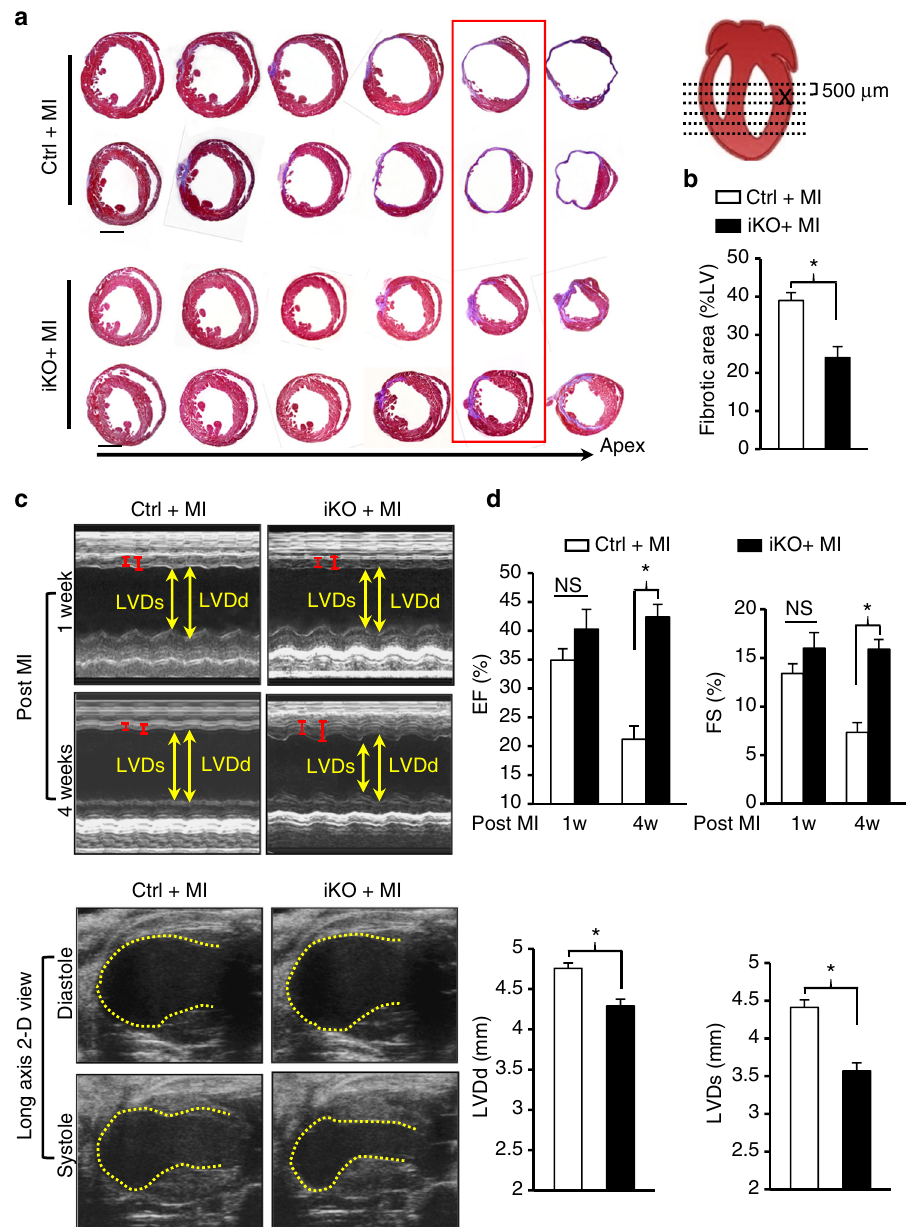
Fig. 9 MiR-128 deletion promotes adult cardiac regeneration after MI. a Representative images of Masson trichrome-stained heart section at 28 days after MI. Serial sectioning was performed at 500 µ m intervals. The most signi fi cant difference between two groups is highlighted by the red box. Scale bars, 1 mm. b Measurement of fi brotic areas in heart sections following MI in control and iKO mice analyzed by Masson trichrome staining. ( n = 8). c , d Heart function analyzed by echocardiography and quanti fi ed by LVDd, LVDs, EF, and FS ( n = 6). Control (Ctrl) mice were miR-128 fl / fl mice, iKO mice were α - MHC MerCreMer ; miR-128 fl / fl mice. Statistical signi fi cance was calculated using Student ’ s t -test in b , d . Data are represented as means ± SEM. * P < 0.05. NS, not signi fi Mice with doxycycline-inducible CM-speci fi c overexpression of miR-128 ( miR- conditional knockout (cKO) region and homology arms, the targeting construct 128-3p ) were generated by crossing α -MHC -tTA (The Jackson Laboratory) mice also contains Frt sites fl anking the neomycin cassette for positive selection and a with miR-128 TetRE mice, in which tetracycline-responsive transcriptional activator DTA cassette for negative selection. The construct was linearized with NotI and (tTA) expression is under the control of α -MHC promoter. Doxycycline (Dox, electroporated into C57BL/6N ES cells. After G418 selection, three-positive clones Harland Laboratories) containing diet was administered to repress transgene were identi fi ed from 280 G418-resistant clones by PCR screening. The positive expression. clones were expanded and further analyzed by Southern blot. The random inte- gration of extra copies of targeting construct was excluded by hybridization with a neomycin probe. To generate chimeras, ES cell clones were microinjected into Generation of mice with a conditional deletion of miR-128 . A construct was blastocysts, and the blastocysts were implanted into pseudo-pregnant foster mice engineered for conditional disruption of the miR-128 ( miR-128-3p ) gene in which a by Cyagen Biosciences Inc. Chimeric males were bred with Flp deleter mice 1.7kb fragment spanning the miR-128 gene was fl anked by two loxP sites. The 1.7 from Jackson Laboratories to generate neomycin-free fl oxed mice. The correct kb fragment, the 5.4 kb left homology arm, and the 2.9kb right homology arm were integration of loxP sites and the successful removal of the neomycin cassette were ampli fi ed from C57BL/6 BAC DNA and cloned into the pBasicLFNeoFL vector con fi rmed by PCR analysis with the primer listed in Supplementary Table 1. sequentially by in-fusion cloning and con fi rmed by sequencing. In addition to